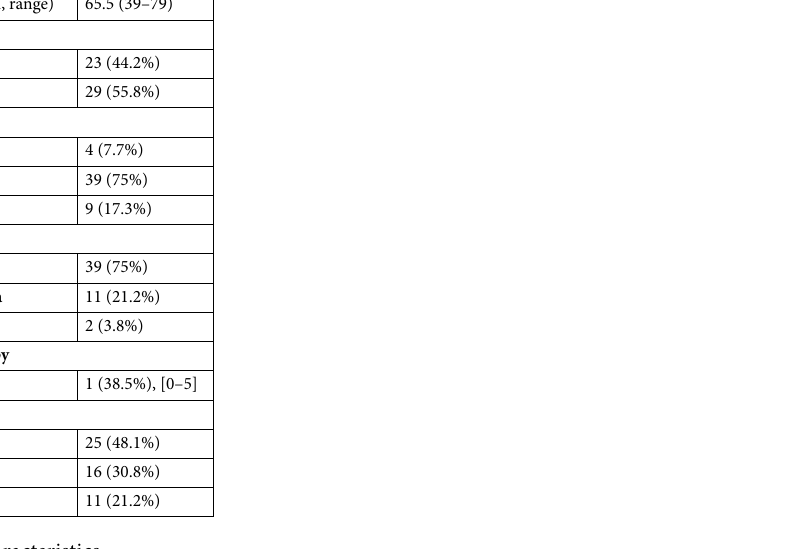
Table 2. Patient